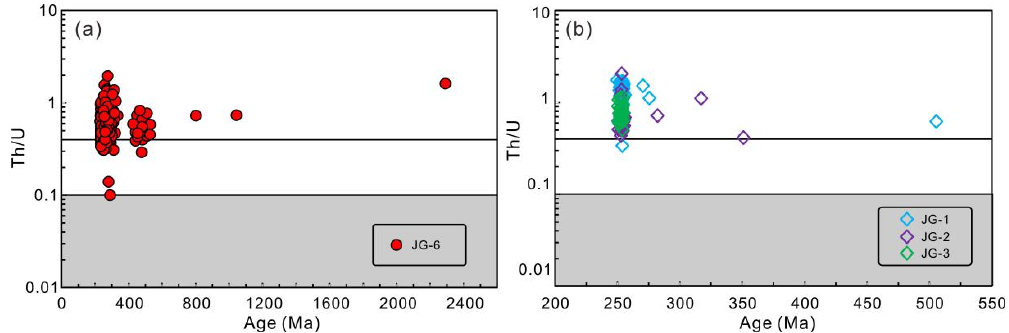
Figure 6. ( a ) U–Pb concordia and ( b ) probability diagrams of zircon ages for the conglomerate sample JG-6.